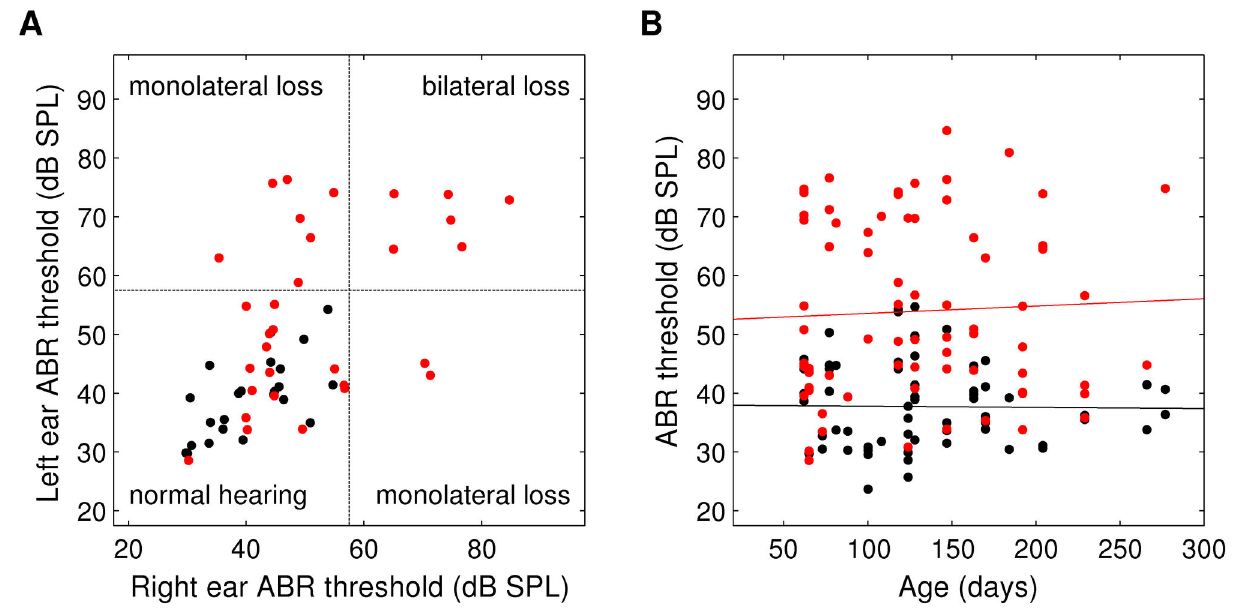
Figure 2. ABR deficit in Df1/+ mice is often monolateral, and shows no age dependence. (A) Click ABR thresholds recorded in left versus right ears, for WT (black) and Df1/+ (red) mice in which both ears were tested. Dashed line indicates criterion threshold for a significant click ABR deficit. (B) Click ABR thresholds versus age, for all ABR recordings. Solid lines indicate best-fit regression lines. Slopes were not significantly different from zero for recordings from either WT (black; slope 95% CI [-0.047, 0.072]) or Df1/+ (red; slope 95% CI [-0.072, 0.030]) animals. To ensure visibility of overlapped data points, zero-mean, 1 dB SPL standard-deviation Gaussian noise was added to threshold data in both A and B for